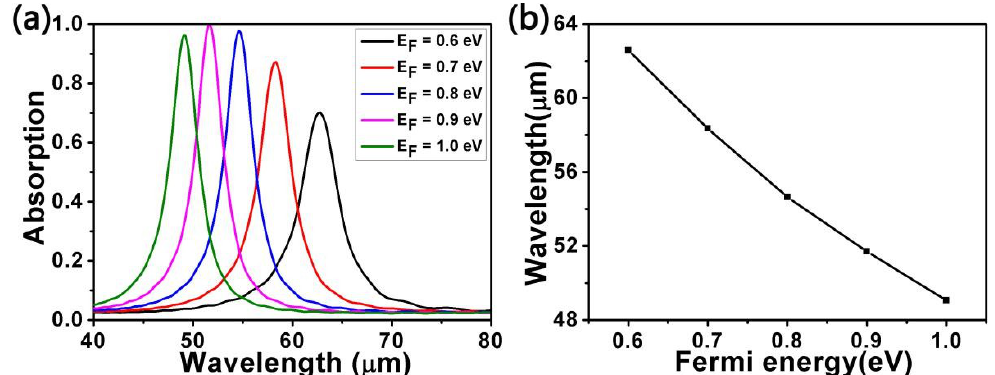
Figure 5. ( a ) Absorption spectra for different Fermi energy ( E F ) values with other parameters fixed. ( b ) The relationship between Fermi energy and the resonance wavelength.